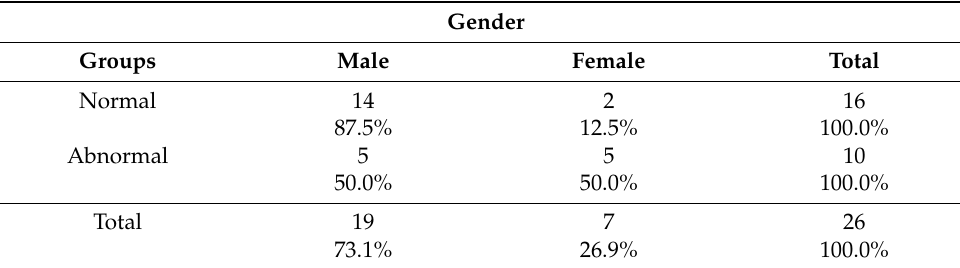
Table 2. Distribution considering gender in the Normal and Abnormal BAEPs groups.